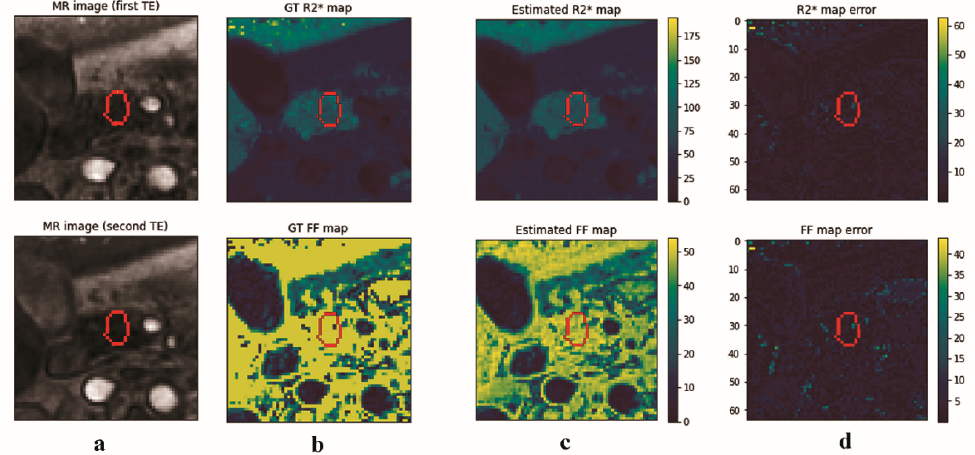
Figure 3. Comparison of ground truth (GT) and estimated R2* and FF maps. The ROI traced for the clinical measurement is over-imposed in red. ( a ) MR image (first and second TEs displayed); ( b ) GT R2* and FF maps; ( c ) estimated R2*and FF maps; ( d ) absolute difference between GT and estimated maps. Estimated and ground truth mean R2* values evaluated in the three pancreatic re- gions were not significantly different (R2*: 43.65 ± 21.89 vs. 43.77 ± 19.81, p = 0.692, ICC =